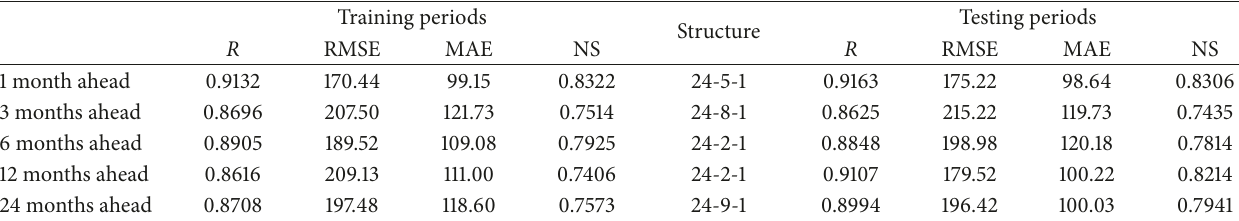
Table 7: Performance of the ANN model with two input variables (precipitation and air temperature) during the training and testing periods for 1-, 3-, 6-, 12-, and 24-month-ahead runoff forecasting in the YARHR. Training periods